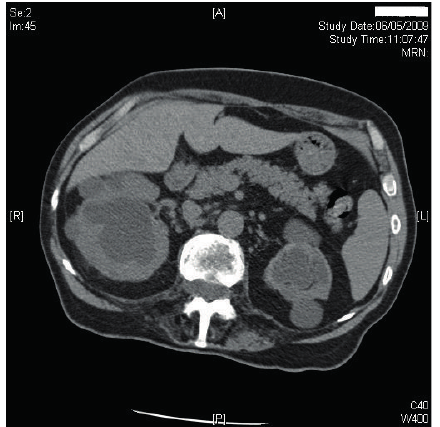
Figure 4: Computed tomography of abdomen revealed marked right hydronephrosis and mild-to-moderate left